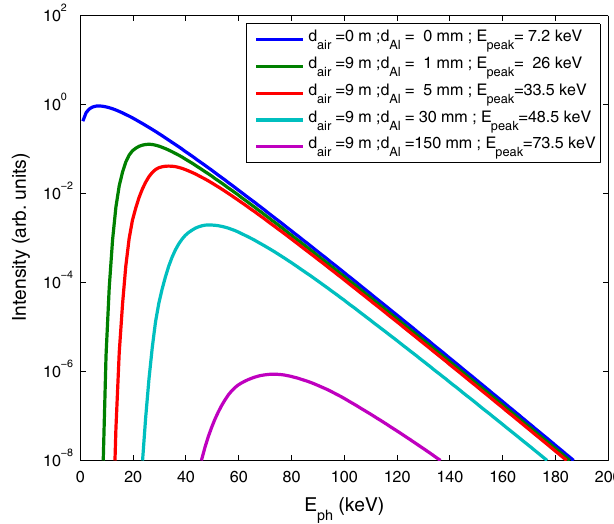
FIG. 3. (Color) Spectrum of the synchrotron radiation in vacuum and also filtered by Al window and 9 m of air (for the case of Diamond). The thickness of the Al window and the peak of the spectrum are shown in the legend. We have chosen an extreme case with an Al window of 150 mm in order to show a large shift towards the higher energies, which could be exploited in higher energy machines than Diamond as the flux also would be higher.